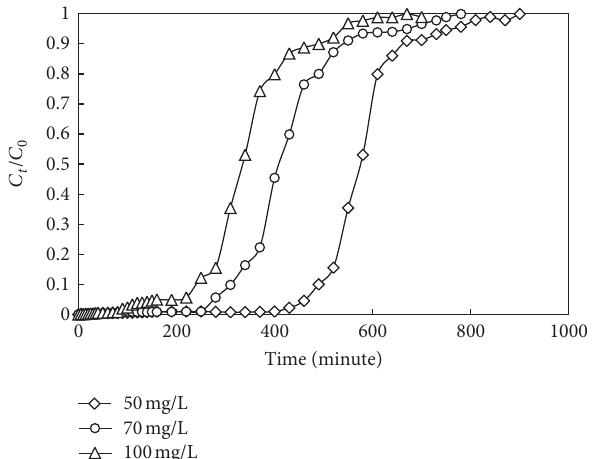
F 3: Breakthrough curves for adsorption of